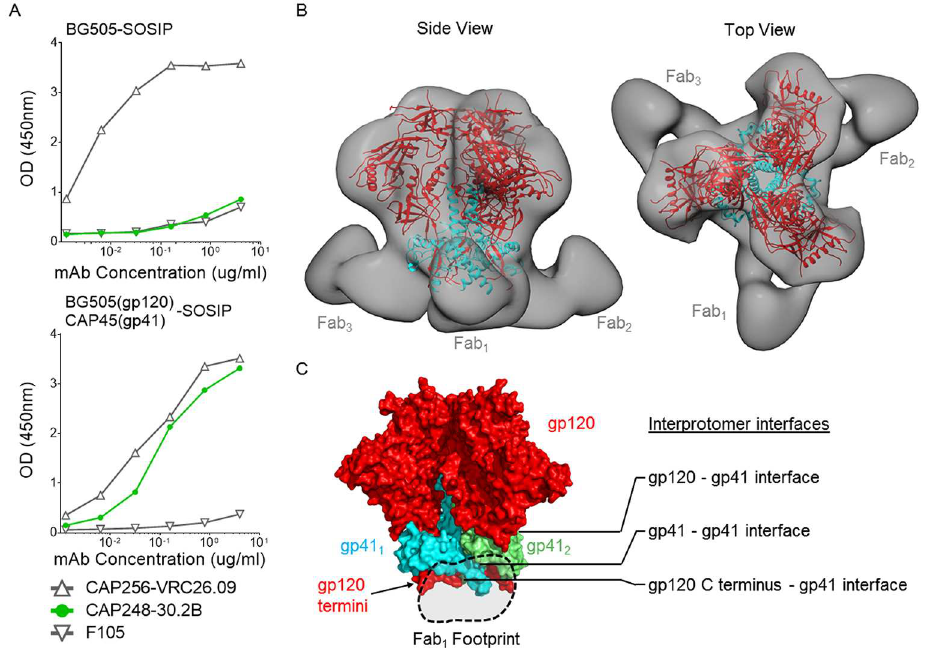
Fig 4. Negative-stain EM reveals a distinct membraneproximal epitope for CAP248-2Bin the gp120 C terminus and parts of gp41. (A) ELISA data comparing the bindingof trimer-specific antibodies CAP256-VRC26.09,CAP248-2B, and the non-neutralizing, gp120bindingantibody F105 to purifiedwild-type BG505 (top panel), and chimeric BG505(gp120)-CAP45(gp41)(bottom panel)SOSIP trimers. Absorbance readingsare plotted on the y-axis and antibodyconcentration on the x-axis. (B) Negative stain EM 3D reconstruction of the CAP248-2BFab boundtrimers, shown in grey. The previously determined trimer structure with pdb ID: 4TVP was docked into the 3D reconstruction, and colored red for gp120 and cyan for gp41. Two views are shown: Perpendicular to the viral membrane(side view), and a view as seen from the target cell (top view). (C) A surface representation of the SOSIP trimer, where all gp120s are colouredred and two adjacentgp41s are shown in cyan and lime green. The gp120-gp41interface, gp41-gp41interface, and gp120 C terminus-gp41 interface are indicated, and the approximate CAP248-2B Fab footprint is shownwith the dotted